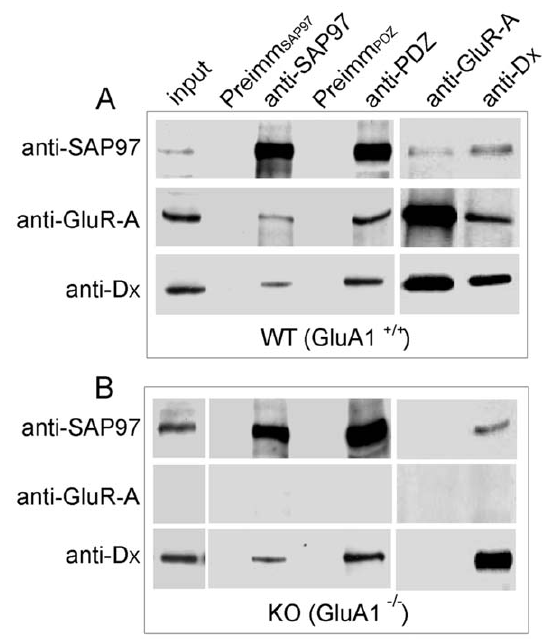
Figure 3. Native GluA4 AMPA receptors interact with SAP97. Whole brain detergent extracts prepared from (A) wild-type (WT, GluA1 + / + ) and (B) GluA1 knockout mice (GluA1 2 / 2 ) were subjected to immunoprecipitation. Immunoprecipitating antibodies are indicated on top; whereas antibodies used for detection of the immunocomplexes are shown on the